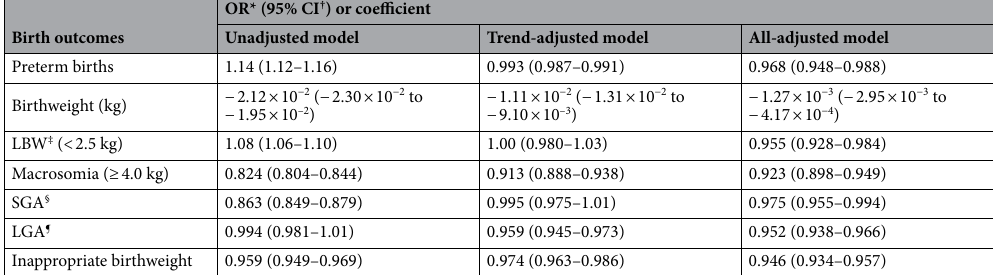
Table 2. Odds ratios or coefficients of adverse birth outcomes in SARS-CoV-2 pandemic period compared to pre-pandemic period. Odds ratios or coefficients estimated from model 1: the unadjusted univariable model; model 2: trend-adjusted; and model 3: adjusted for for parental age, gestation age, parental education level, marital status of parents, parity, and months from January 2011; are shown. *OR: odds ratio. † CI: confidence interval. ‡ LBW: low birthweight, < 2.5 kg. § SGA: small for gestational age. ¶ LGA: large for gestational age.